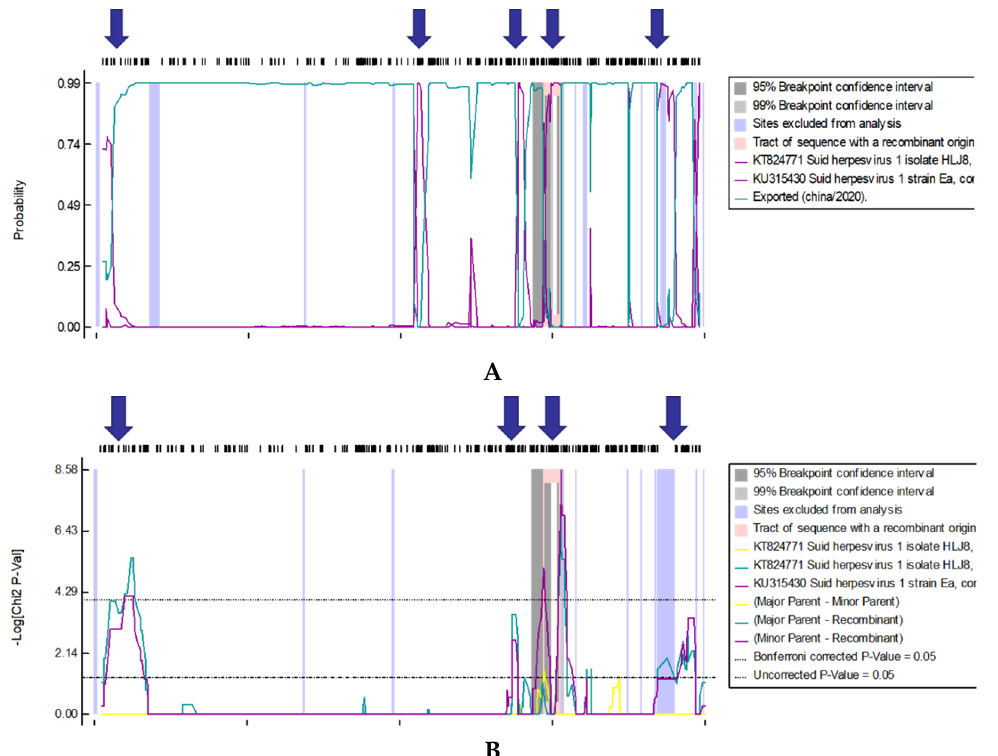
Figure 5. Putative recombination events in the PRV FJ strain complete genome. Recombination sites